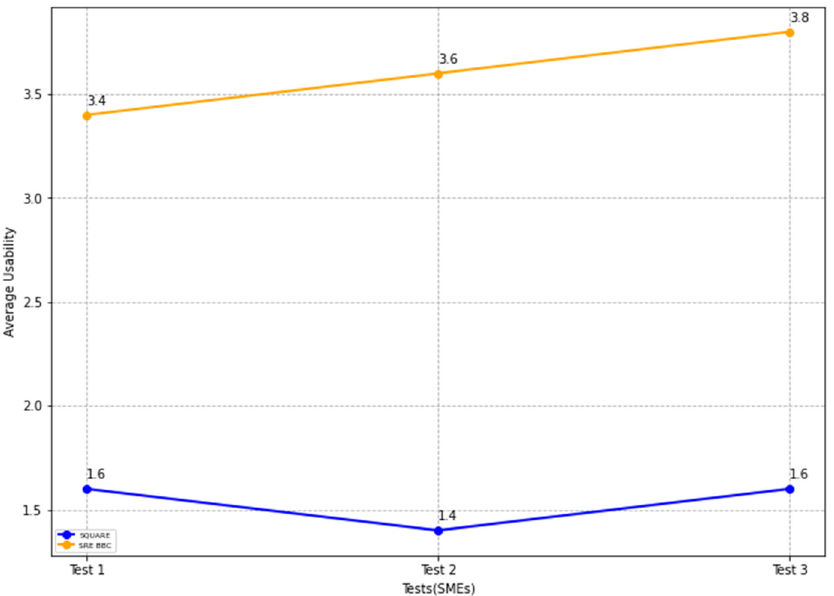
Figure 23. The comparison of quantified average usability level score for SQUARE and SRE_BBC (Replicated Study).